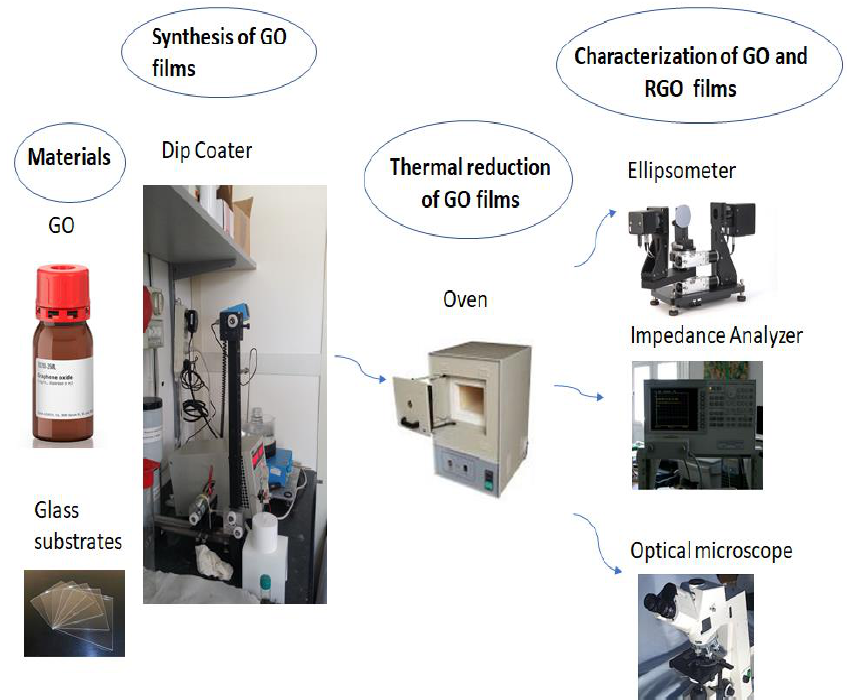
Scheme 1. Schematic diagram of the synthesis process.